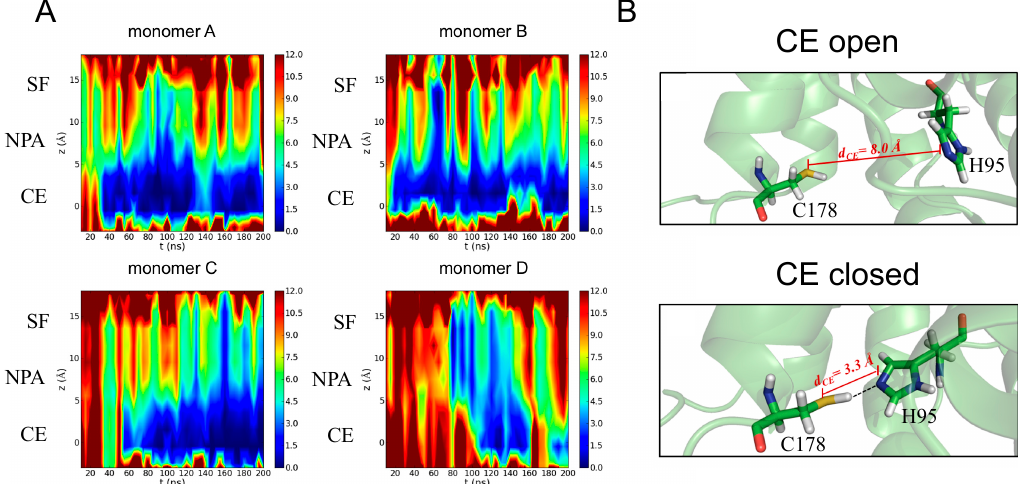
Figure 4. Gating site at the the cytoplasmic end (CE) region. ( A ) Color plots depicting the time dependence of the local osmotic permeability (10 − 14 cm 3 /s) computed for the four monomers; ( B ) Selected frames showing different states ( open and closed ) of the CE region. The H-bond interaction occurring between C178 and H95 residues and causing the closed state is depicted by a dotted line. Adapted from reference [22].